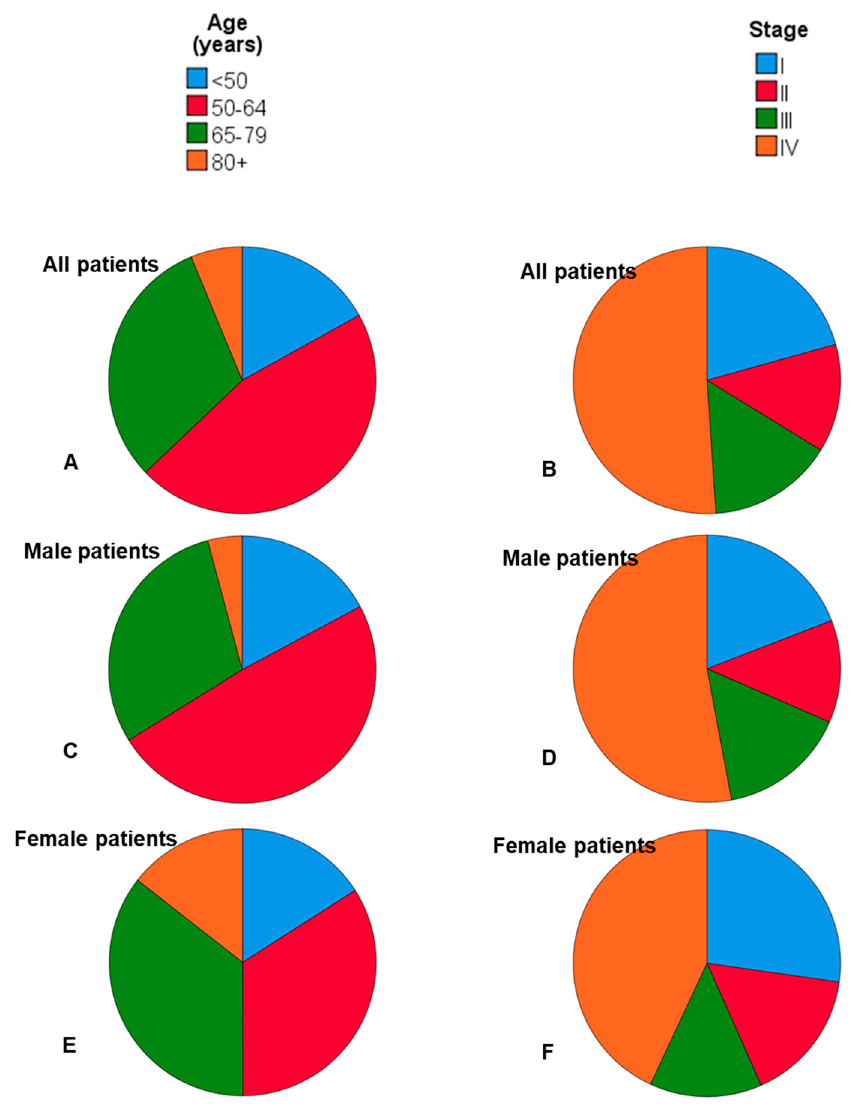
Figure 1. Distribution of age ( A , C , E ) and tumor stage ( B , D , F ) in all patients ( A , B ), male patients ( C , D ), and female patients ( E , F ).